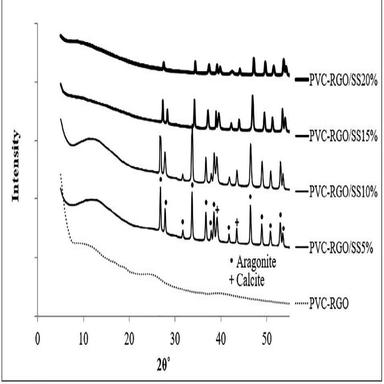
X-ray diffraction patterns of PVC-RGO composite and biocomposites.